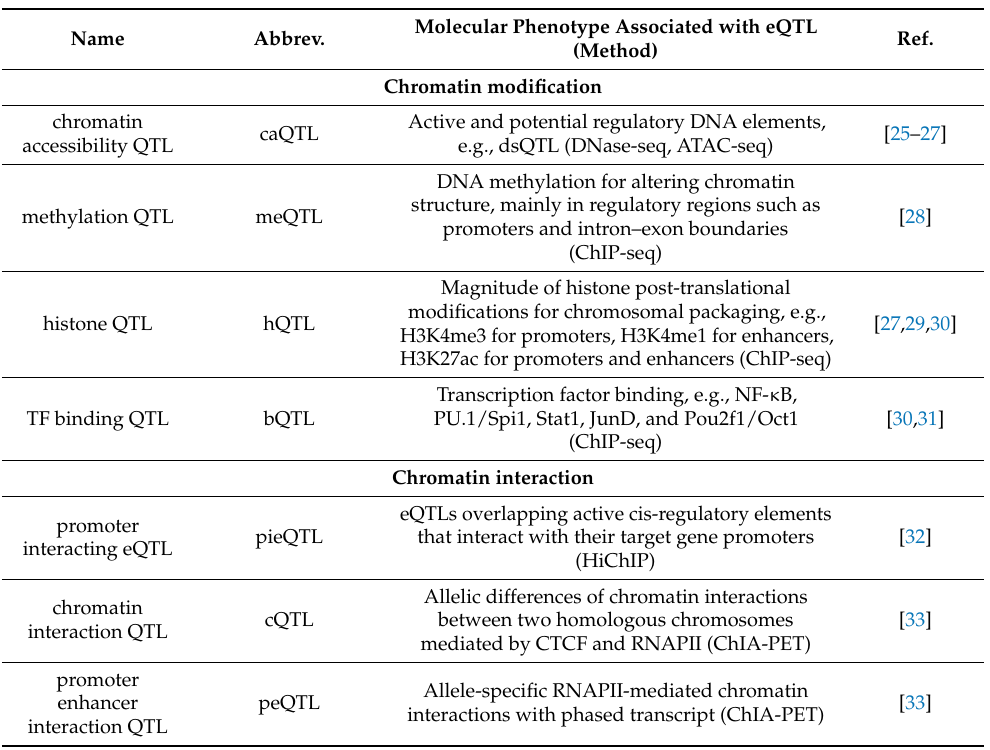
Table 2. Types of expression quantitative trait loci (eQTLs) associated with various molecular